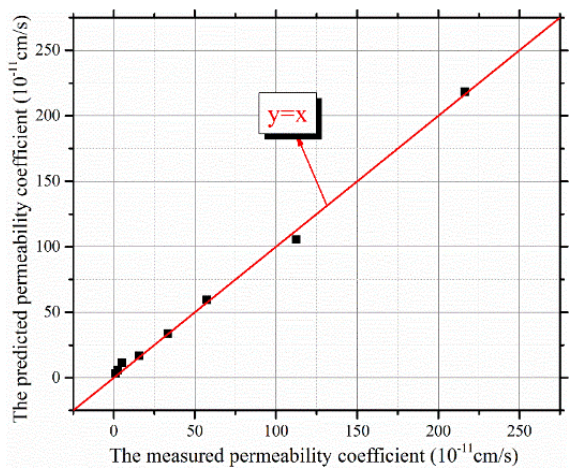
Figure 12. The predicted permeability coefficients versus the measured permeability coefficients. Red solid line indicates a slope of 1:1. The closer the black point is to the line, the smaller the difference between the predicted and measured permeability coefficient is.